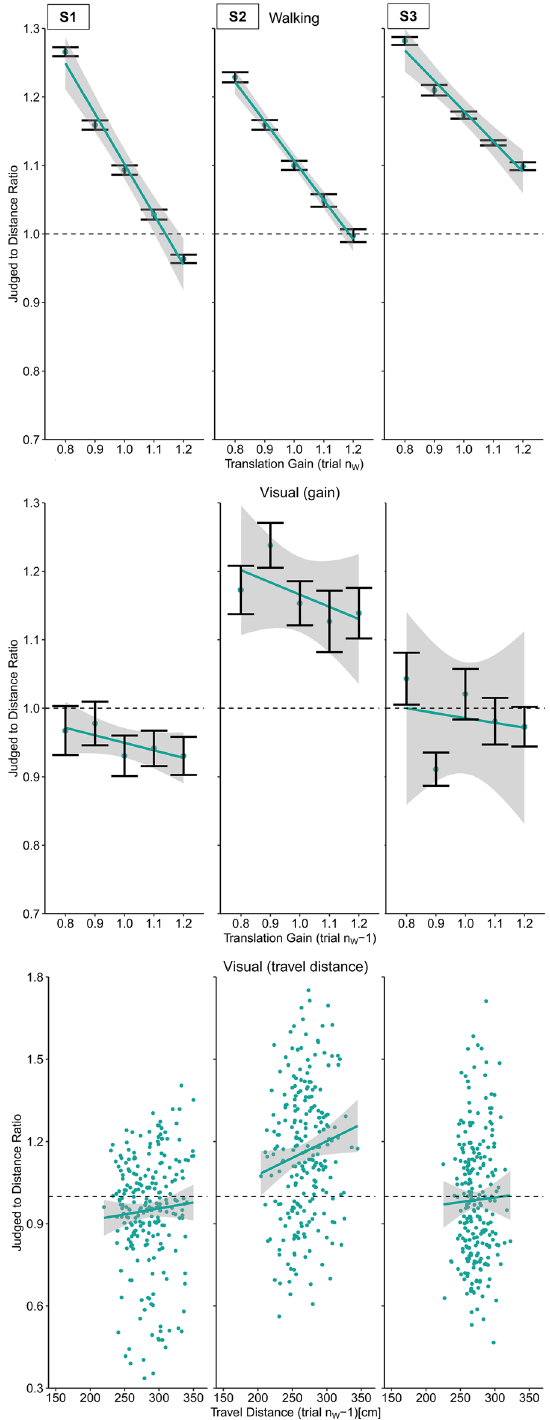
Figure 8. Results of Experiment 4 (physical walking until prompted to stop with optic flow) for three example participants. Upper panel: Regression between the translation gain in trial n W and judge to distance ratio for walking distance estimations in trial n W . Middle panel: Serial dependencies quantified by the regression between the translation gain in in trial n w − 1 and visual distance judgements. Lower panel: Serial dependencies quantified by the regression between travel distance in trial n w − 1 and visual distance judgements. Error bars represent the SEM and the grey areas represent the 95% confidence